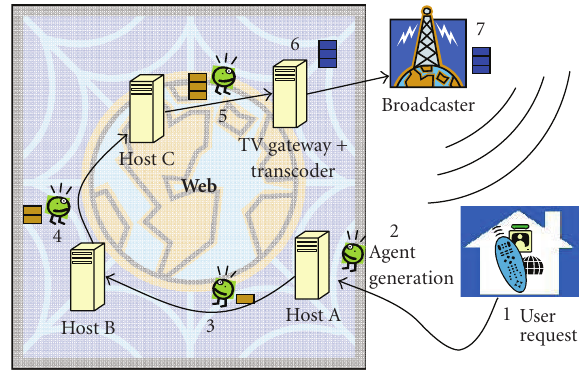
Figure 1: The system